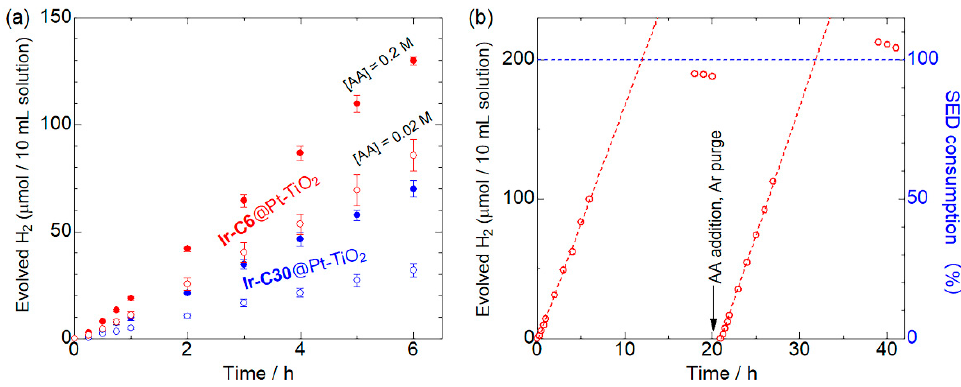
Figure 6. ( a ) Photocatalytic H 2 evolution reaction driven by the Pt-cocatalyst-loaded TiO 2 nanoparticles Ir-C6@Pt-TiO 2 (red) and Ir-C30@Pt-TiO 2 (blue) in 0.2 M (closed circles) and 0.02 M (open circles) L -ascorbic acid (AA) solution ([Ir] = 10 µ M, pH = 4.5, CH 3 CN:H 2 O = 1:1 v / v ) under Ar atmosphere. ( b ) Two-cycle photocatalytic H 2 evolution reaction driven by Ir-C6@Pt-TiO 2 in 0.02 M AA solution ([Ir] = 10 µ M, pH = 4.5, CH 3 CN:H 2 O = 1:1 v / v ) under Ar atmosphere. After the first reaction for 20 h, the AA solution was added to adjust the concentration to 0.02 M, after which the reaction solution was degassed by Ar bubbling for 1 h before the second irradiation. A 300 W xenon lamp (0.25 W) with a longpass filter ( λ > 420 nm) was used as the irradiation source.